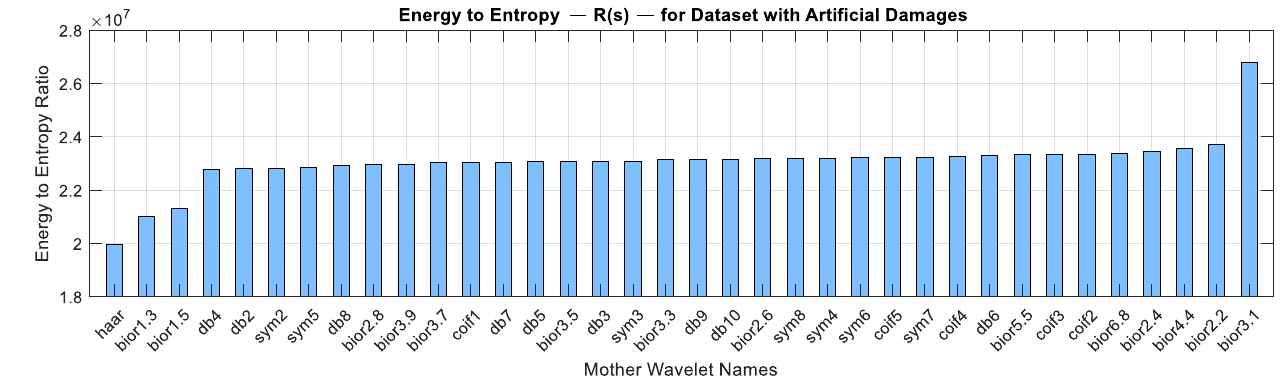
Figure 6. Energy to Entropy ratio for artificial damage data.